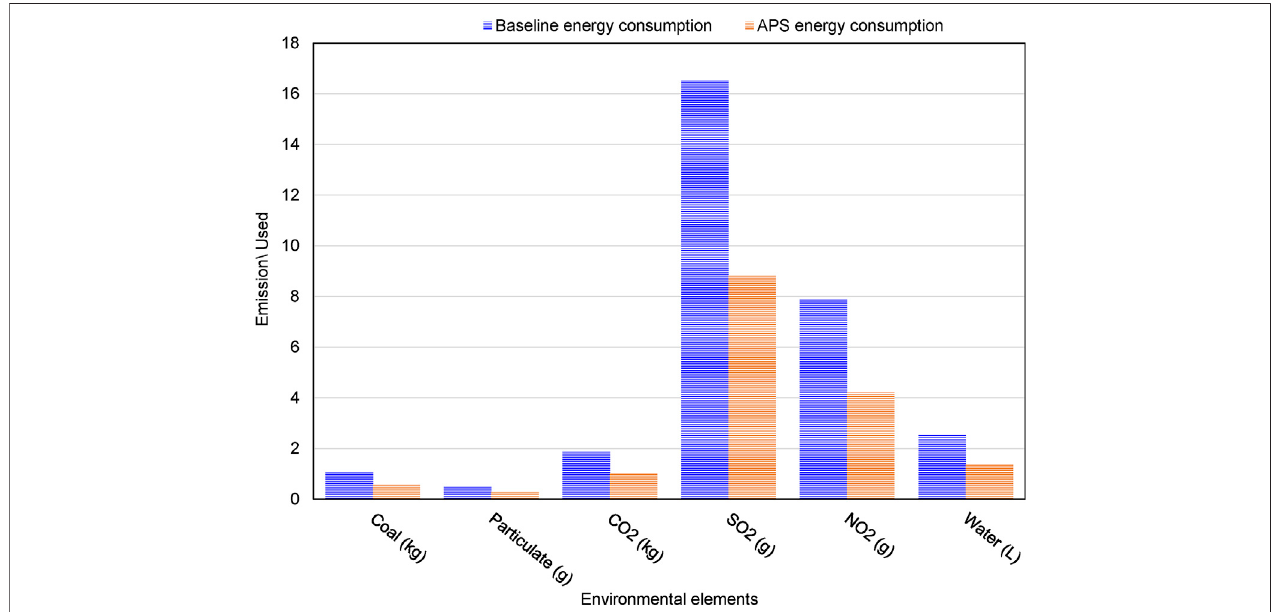
FIGURE 8 | Lighting environmental implications and mitigations of the